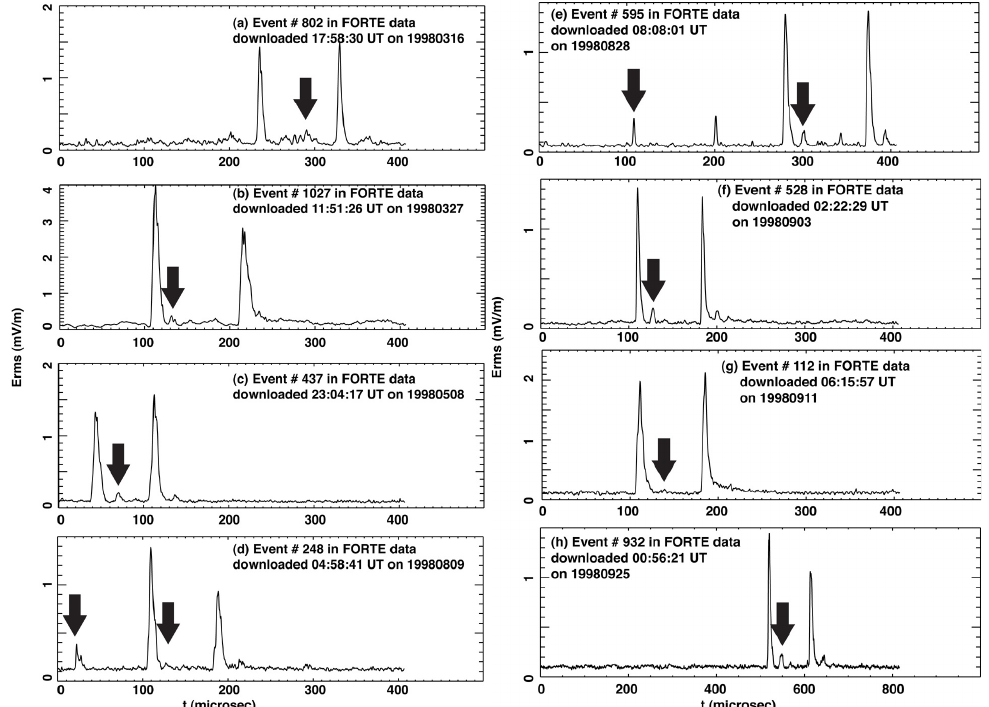
Fig. 11. Root mean square electric field vs. time, with the mean over a 1.5µs sliding window, for each of the eight strong TIPPs in au- tonomously triggered TATR records that were coincident with autonomously triggered PDD. Arrows mark “secondary-breakdown